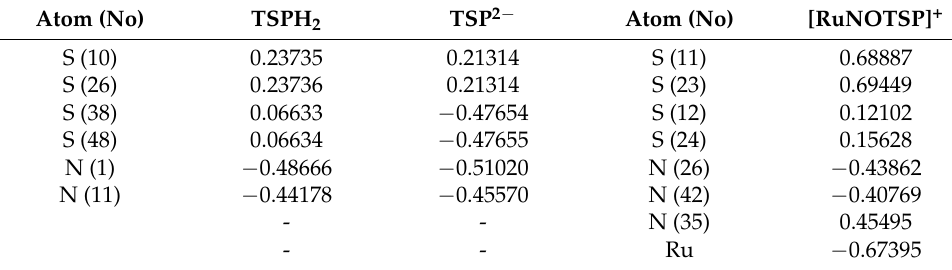
Table 1. NBA charges of selected atoms of TSPH 2 , TSP 2 − anion, and [RuNOTSP] + at B3LYP/3-21G(d).